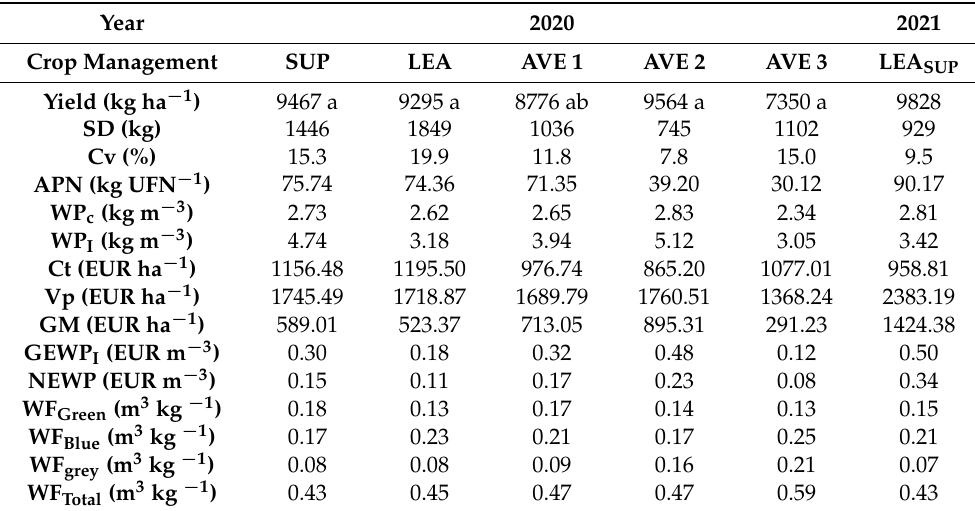
Table 7. Grain yield and water productivity in the different management types in the two barley growing